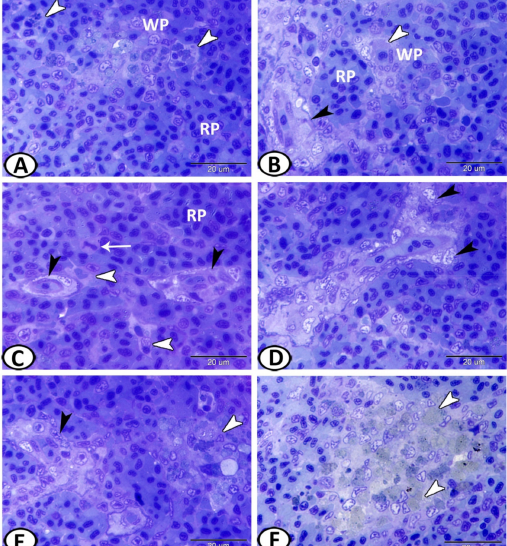
Figure 2. Semithin sections of the spleen stained with toluidine blue. ( A , B ) The spleen of molly fish illustrates the components of the parenchyma, the red pulp (RP), and the white pulp (WP). Note the macrophages (white arrowheads) and ellipsoids (black arrowheads). ( C ) The red pulp (RP) consisted mainly of erythroid cells, which comprised the majority of the splenic parenchyma. Splenic cords were a mesh of fibroblast-like cells (black arrowheads) that typically surrounded ellipsoids. Note the mitotic cells (arrow) and macrophages (white arrowheads). ( D ) The ellipsoids consisted of cuboidal endothelial cells (black arrowheads). ( E , F ) Melanomacrophage centers (white arrowheads) contained varying amounts of pigment localized in close relation to the ellipsoids (black arrowheads).